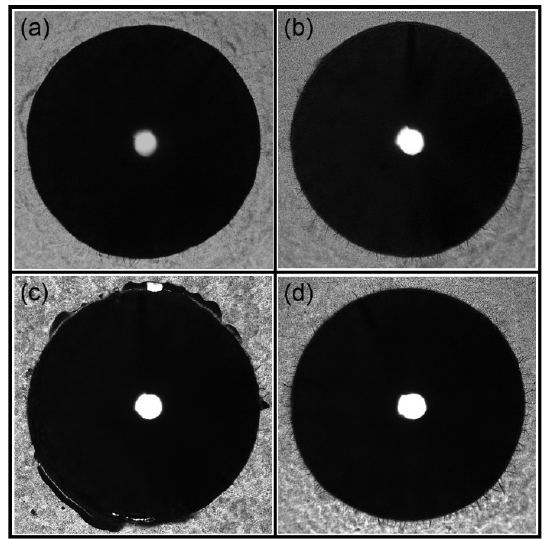
Figure 9. Rockwell indentation of Cr coatings at different powers: ( a ) 100 W; ( b ) 150 W; ( c ) 200 W; ( d ) 250 W.